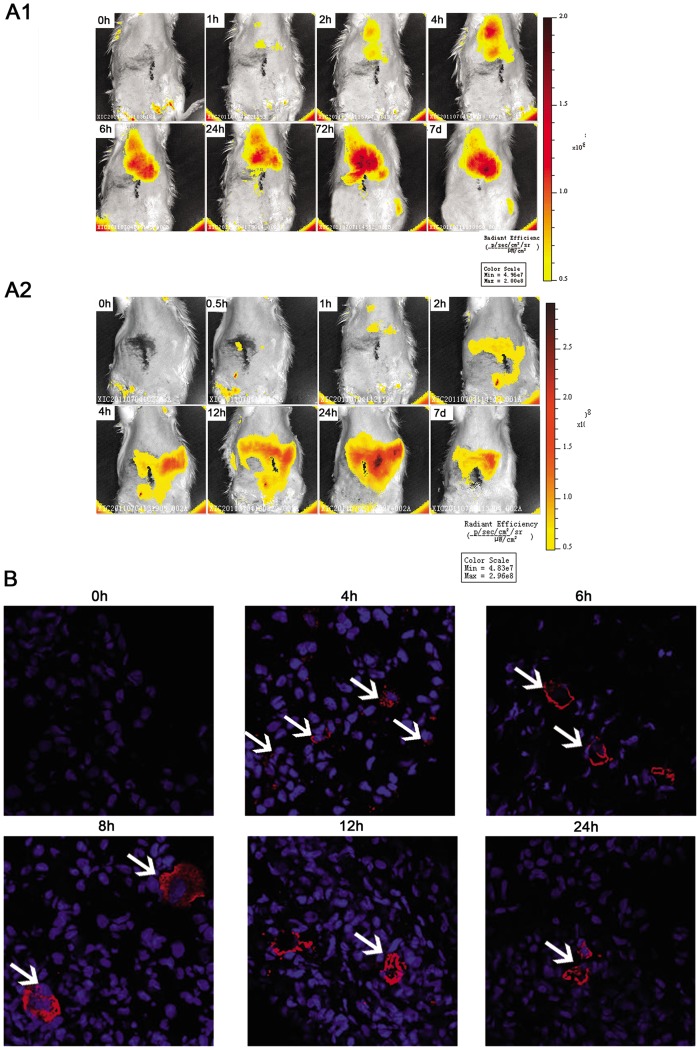
Tracking the distribution of mesenchymal stem cells (MSCs) injected into rats.(A1). In vivo imaging revealed that MSCs injected via tail vein first accumulated in the lungs and gradually in the liver and the spleen. (A2). In vivo imaging revealed that MSCs injected intraperitoneally first accumulated in the liver and gradually in the spleen. No signal was found in the injured peritoneum. (B). An immunofluorescence evaluation of green fluorescent protein (GFP) (red) detected MSCs in the lungs. Nuclei were stained with DAPI (blue). Magnification  = ×1000.